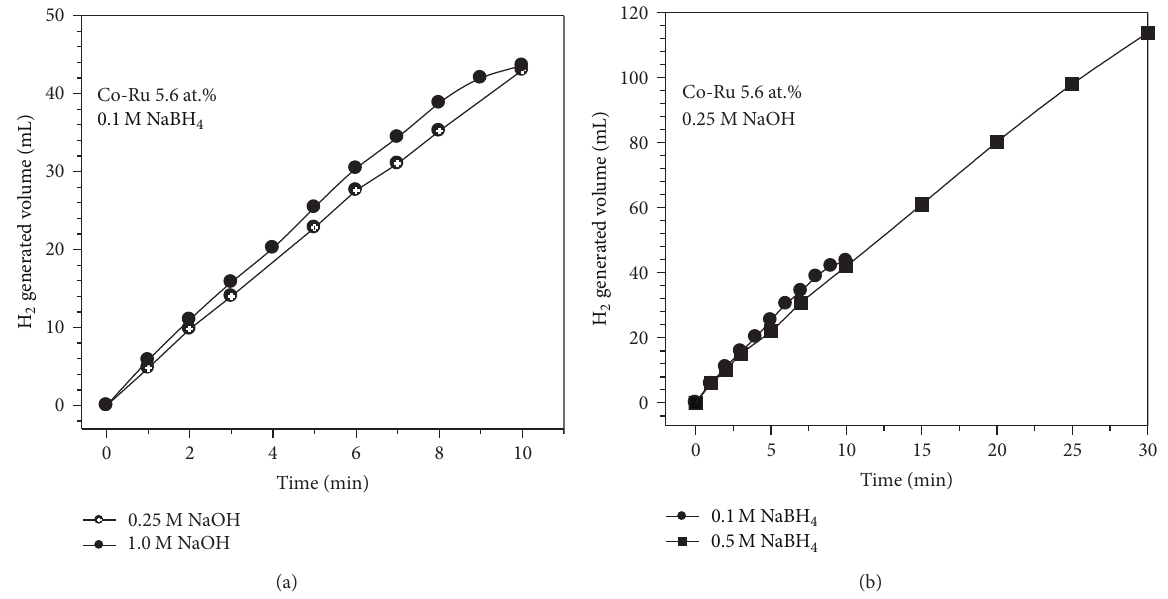
Figure 7: Volume of hydrogen generated as a function of time and the composition of solution applied for the Co-Ru (3.8at%) catalyst.